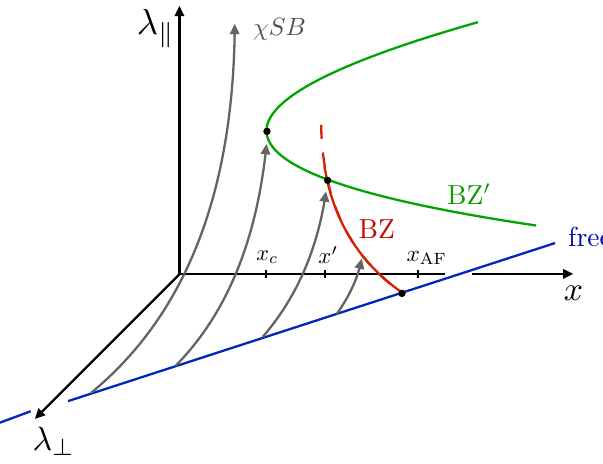
Figure 6 . The non-minimal scenario. We call collectively by (cid:21) G 0 symmetry, and by (cid:21) the couplings which break G 0 to G . The line of (cid:12)xed points BZ 0 lives at ? (cid:21) = 0. The RG (cid:13)ow lines lie in planes of constant x ?